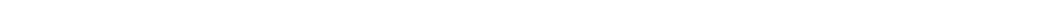
(see fi gure on previous page) Fig. 3 PPAR γ /RXR α heterodimer condensates prefer to enrich at PPRE sites to promote target gene expression. a Co-immunostaining of PPAR γ (green) and RXR α (red) in 3T3-L1 cells before and after differentiation ( n = 10). Pre-adipocyte (undifferentiated) 3T3-L1 cells were grown to con fl uence (~48 h) and induced by IBMX, insulin and dexamethasone (day 0). The cells were induced to differentiate by changing to the media containing insulin (day 2) and then media were changed every two days. The differentiated adipocyte cells were fi xed at day 0 (D 0), day 4 (D 4), and day 8 (D 8) and then immuno fl uorescence staining was performed. The white line displays nuclear periphery, determined by DAPI staining (not shown). Scale bar, 5 μ m. The fourth column (merge (zoom)) displays a magni fi cation of the purple box region in the third column for greater detail. Scale bar, 500 nm. Right panel, a line plot corresponding to magni fi ed image. b Western blot analysis of PPAR γ levels in 3T3-L1 cells before and after differentiation ( n = 3). c The number of PPAR γ /RXR α heterodimer condensates in 3T3-L1 cells before and after differentiation ( n = 10). Data are shown as means ± SEM. d Fluorescence intensities of PPAR γ /RXR α heterodimer condensates in 3T3-L1 cells before and after differentiation ( n = 300). Data are shown as means ± SEM. e RT-qPCR analysis of PPAR γ , aP2 and adiponectin transcription levels in 3T3-L1 cells before and after differentiation ( n = 3). f Colocalization between PPAR γ /RXR α heterodimer puncta and aP2-PPRE locus by IF and DNA-FISH in fi xed 3T3-L1 cells before and after differentiation ( n = 50). Scale bar, 5 μ m. The fi fth column (merge (zoom)) displays the magni fi cation of the purple box region in the fourth column for greater detail. Scale bar, 500 nm. Right panel, the line plot corresponding to magni fi ed image. g Quanti fi cation of DNA-FISH analysis using percentage of cells with PPAR γ /RXR α condensates and aP2-PPRE locus colocalization in fi xed 3T3-L1 cells before and after differentiation ( n = 3). Data are shown as means ± SEM. h Colocalization between PPAR γ /RXR α heterodimer puncta and aP2-PPRE locus by IF and RNA-FISH in fi xed 3T3-L1 cells before and after differentiation ( n = 50). i Quanti fi cation of RNA-FISH analysis using percentage of cells with PPAR γ /RXR α condensates and aP2-PPRE locus colocalization in fi xed 3T3-L1 cells before and after differentiation ( n = 3). Data are shown as means ± SEM. One-way analysis of variance (ANOVA) for panels b , c , d , e, and g . Two-tailed unpaired t -test for panel i . *P < 0.05, ** P < 0.01, *** P < 0.001, **** P < 0.0001. ns, not signi fi